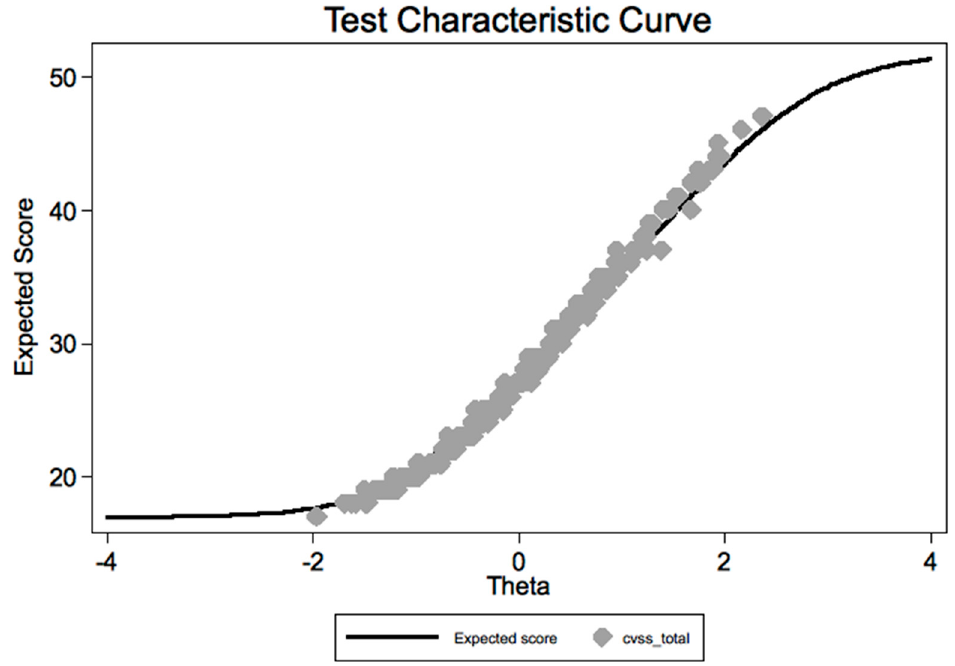
Figure 7. Test characteristic curve (TCC): CVSS summated score vs. predicted score from the graded response model (IRT analysis) of the Italian version of the CVSS.